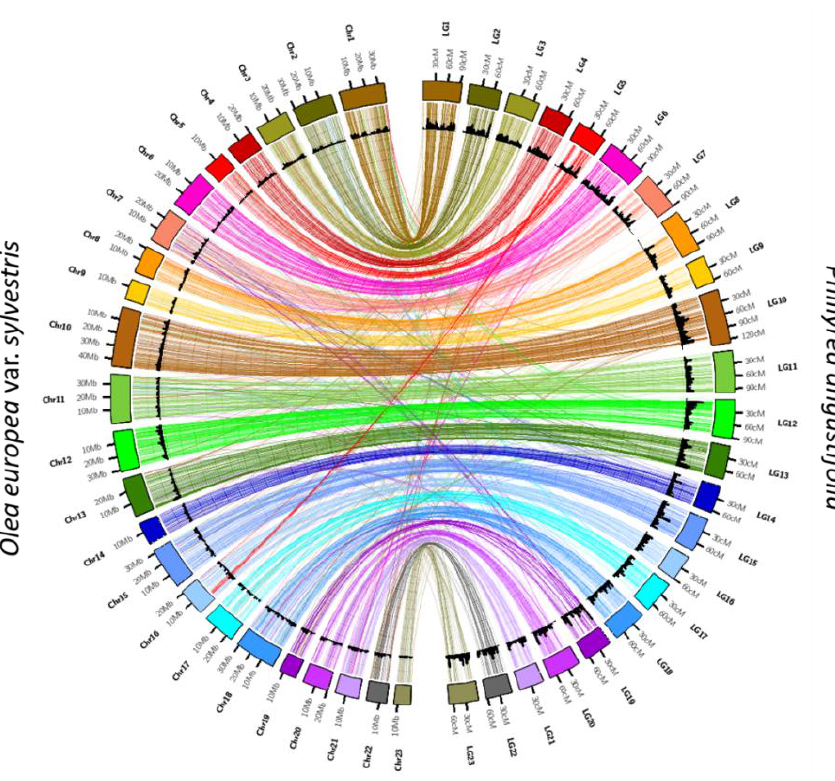
Figure 3. Synteny plot identifying homologous P. angustifolia linkage groups (LG, scale in cM) with olive tree chromosomes (Chr, scale in Mb). Lines connect markers in the P. angustifolia linkage map with their best BLAST hit in the O. europea genome and are colored according to the linkage group. Variation of the density of loci in bins of 3.125cM along linkage groups and 1 Mbp along chromosomes is shown in the inner circle as a black